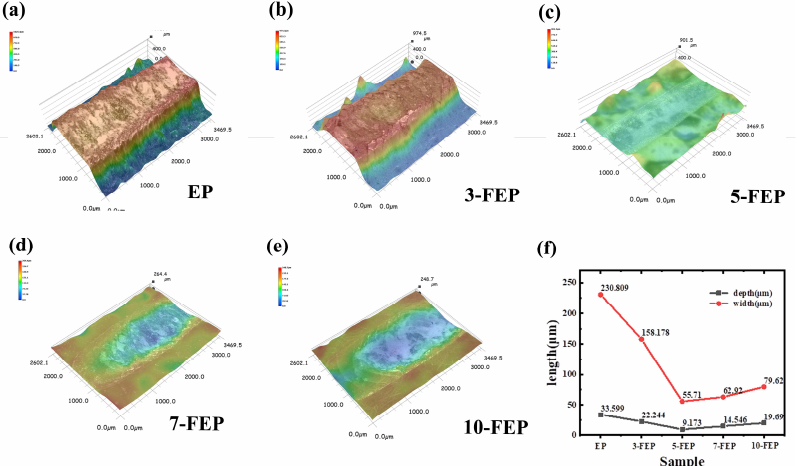
Figure 8. Cross-sectional profile heights and corresponding depth 3D friction patterns for the five coatings: ( a ) EP, ( b ) 3-EP, ( c ) 5-EP, ( d ) 7-EP, ( e ) 10-EP; ( f ) Resistance reduction mechanism.